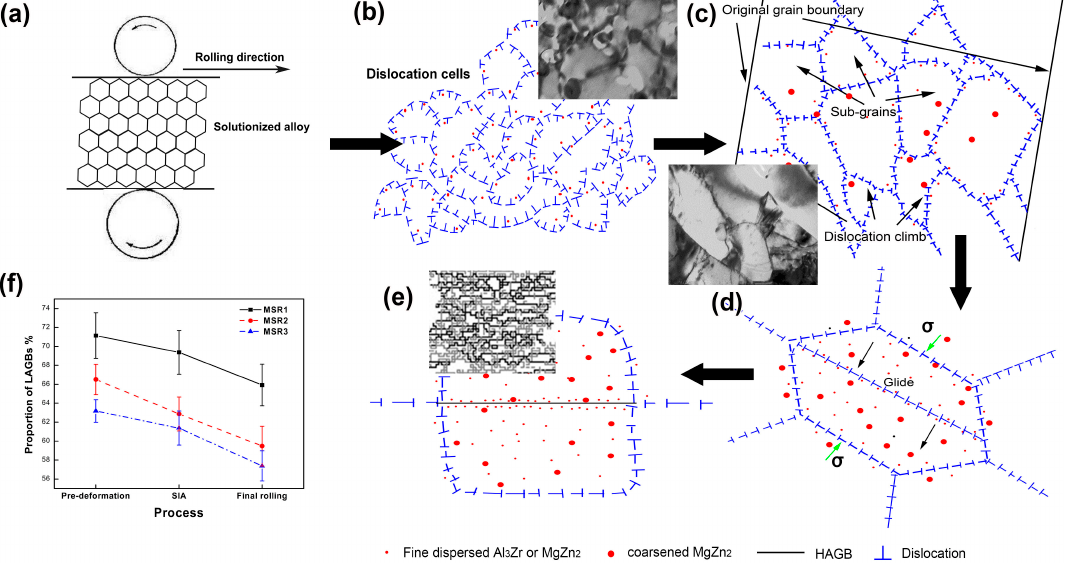
Figure 6. Schematic diagram of grain refinement: ( a ) deformation induced by rolling; ( b ) after pre-deformation; ( c ) after SIA; ( d ) with further hot deformation; ( e ) after final hot rolling; ( f ) statistical diagram of LAGBs.